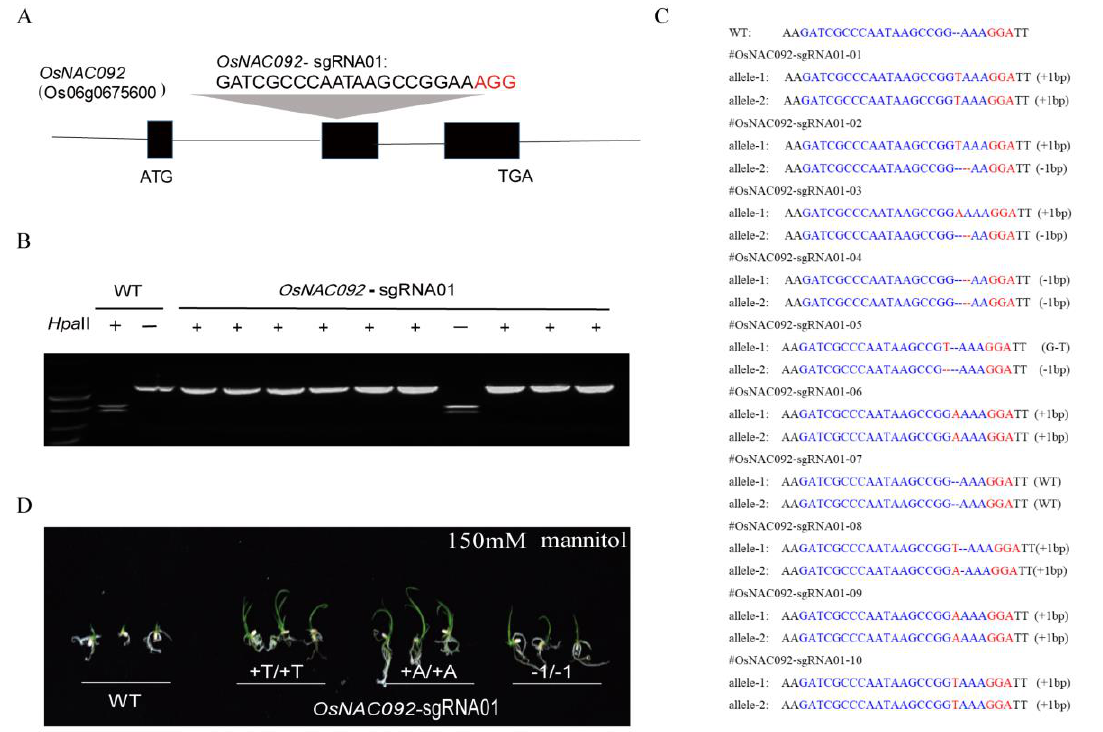
Figure 2. Using CRISPR-Cas9 system to create mutants. ( A ). Design of the sgRNA site for OsNAC092 exons. ( B ). osnac092 T0 genotype digestion test results. ( C ). Sanger sequencing results of osnac092 T0 generation. ( D ). MS + 150mmmol mannitol germination results under simulated drought treatment. osnac092 (T/T) and osnac092 (A/A), insertion of a single base pair (+1 bp/+1 bp). osnac092 (−1/−1), a single base pair deletion (−1 bp/−1 bp).